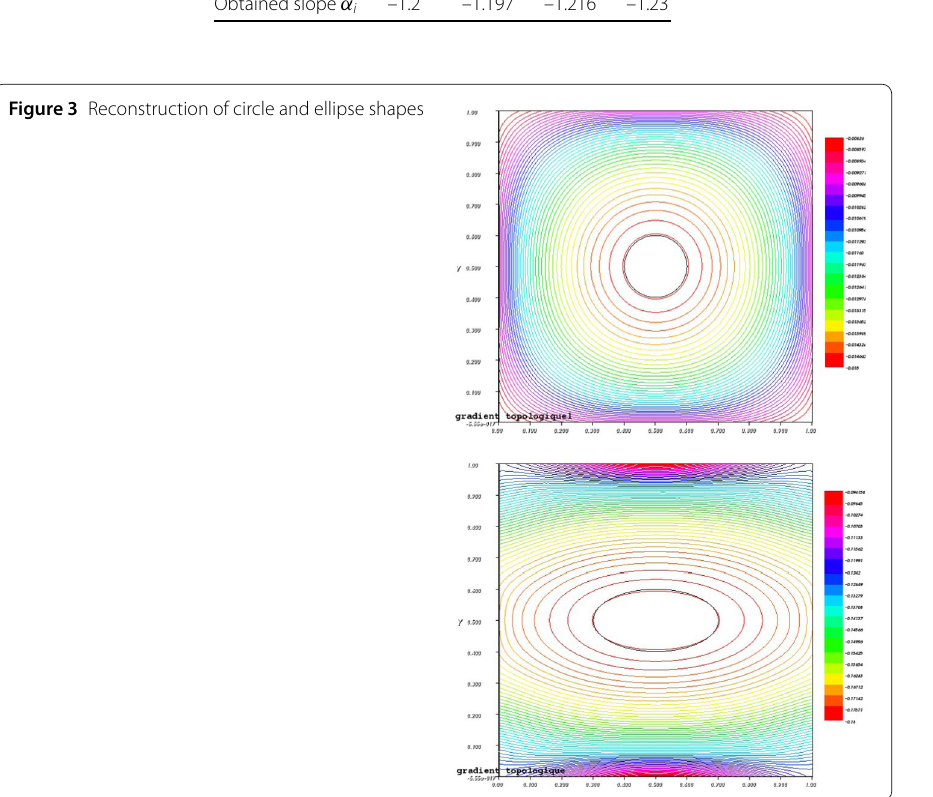
Table 2 Slopes of the lines associated with the obstacles Q z